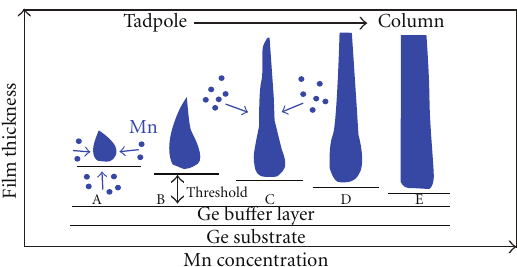
Figure 8: Schematic diagram of the structural evolution of the coherent Mn-rich clusters from tadpoles to nanocolumns in the GeMn thin films. Reproduced from [14]. Copyright ©2010, Elsevier B.V..